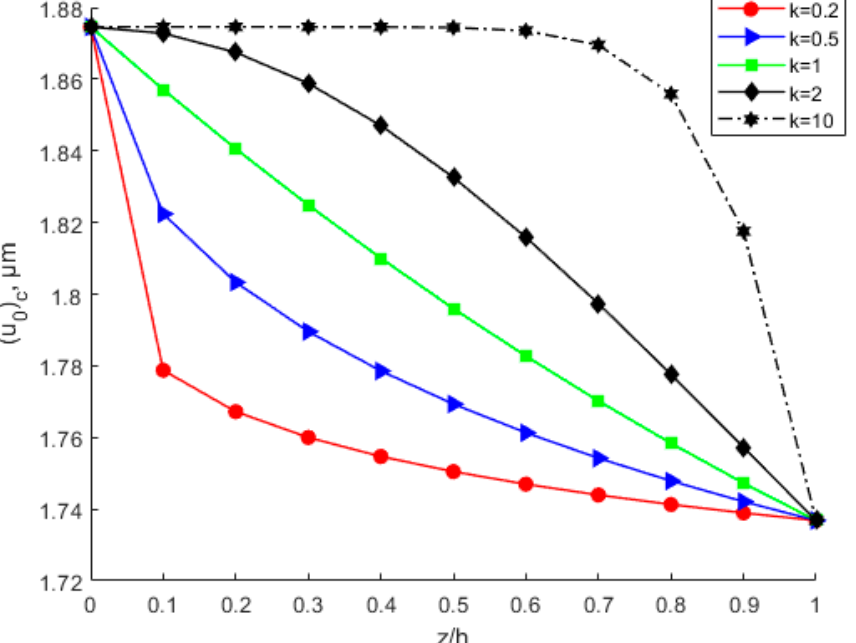
Figure 13. Variation in the x-direction critical displacement through the thickness direction of the FGM plate.